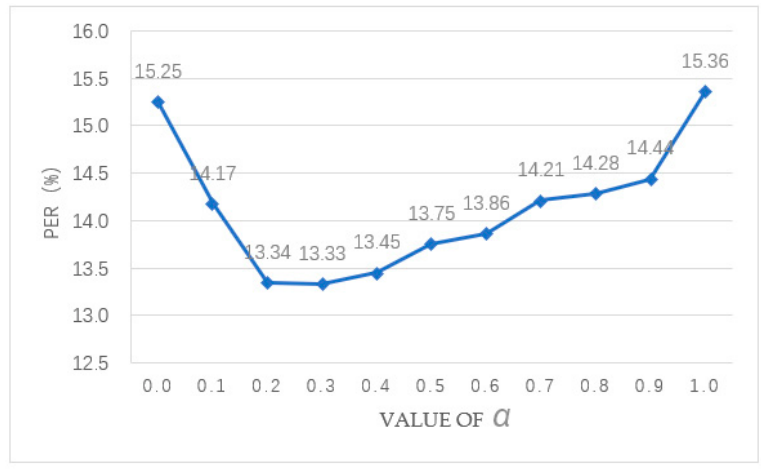
ff ect of the hyper-parameter α in the hybrid Figure 5. Effect of the hyper-parameter a in the hybrid model. Figure 5. E